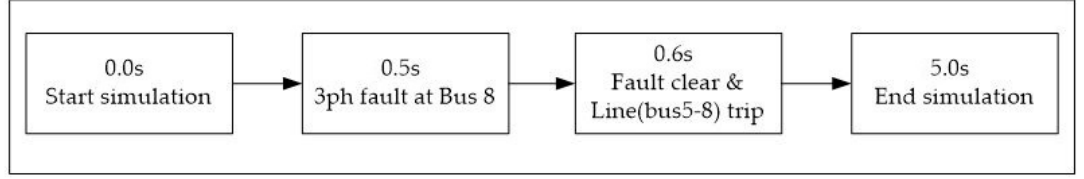
Figure 7. Simulation scenario.